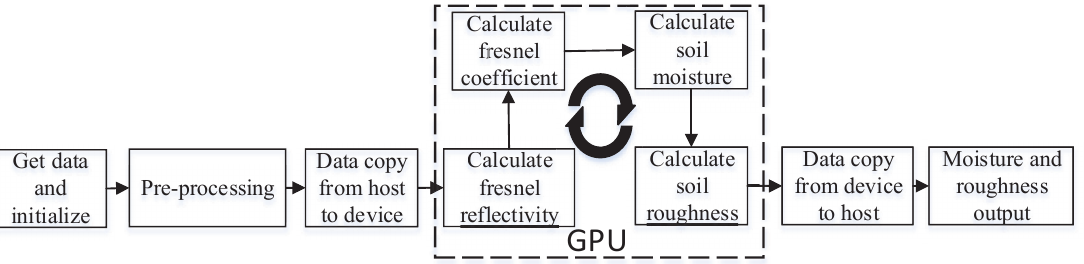
Figure 2. Dubois and Oh inversion algorithm optimization framework.